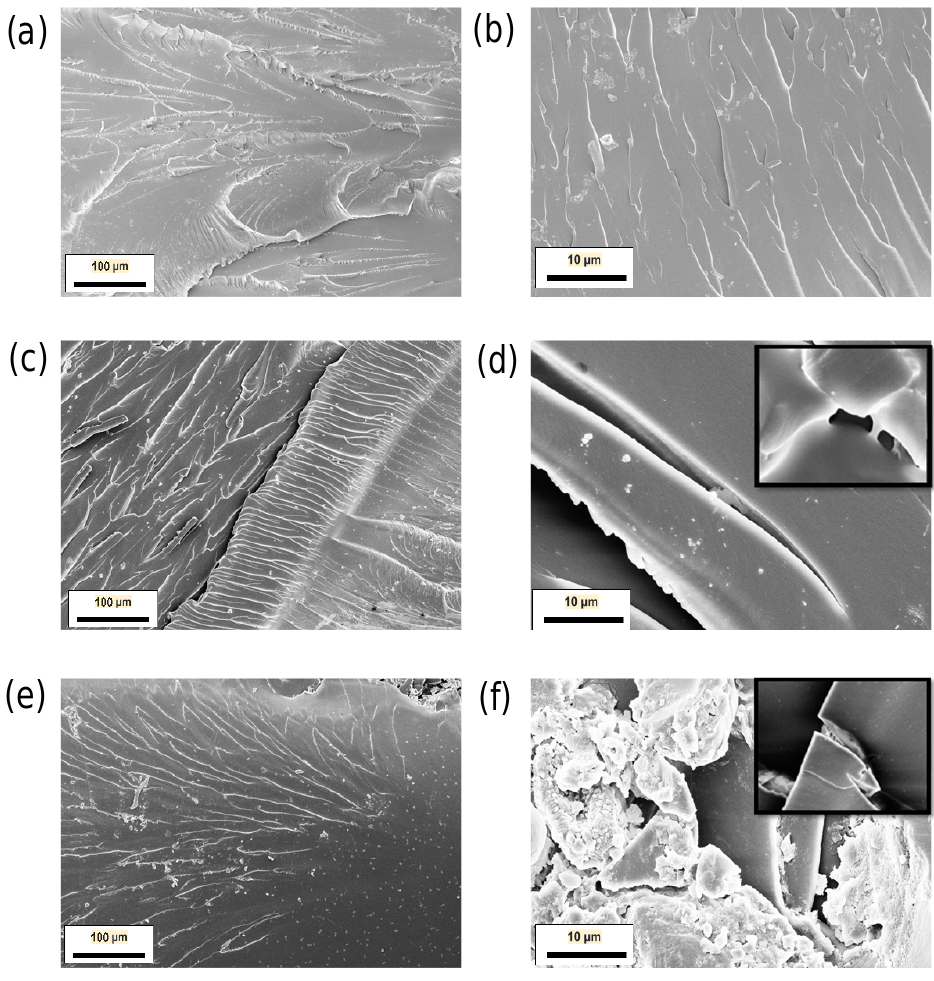
and × and ( d ) 5000 ; and of 0.75 wt % × × and ( f ) 5000 . × ×